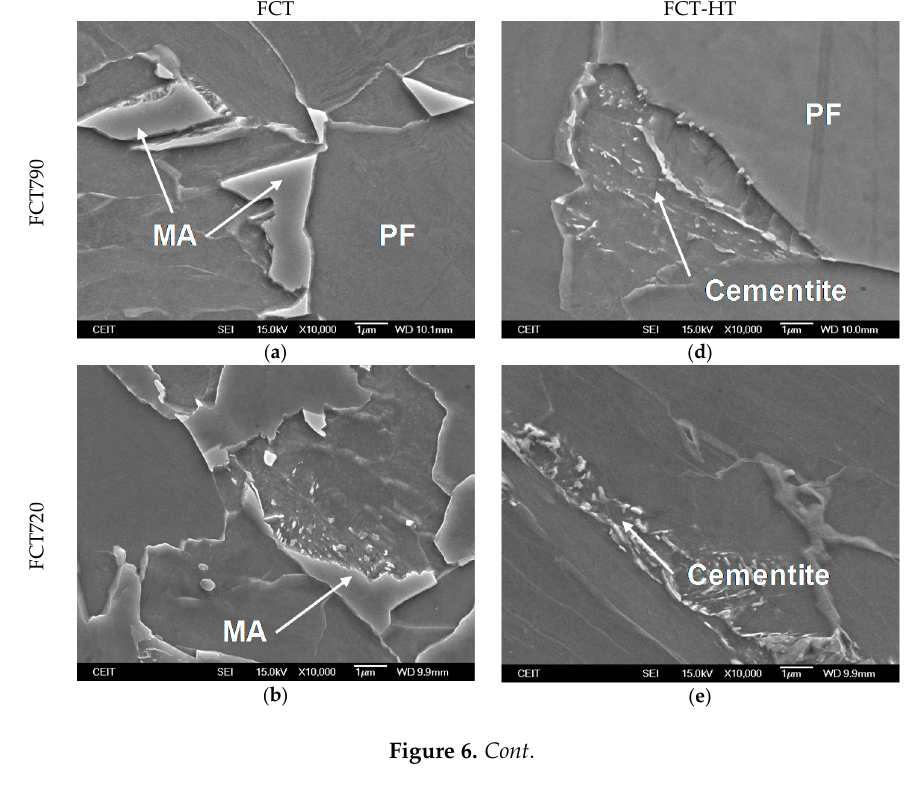
Figure 5. FEGSEM (field-emission gun scanning electron microscopy) micrographs corresponding to every Fast Cooling Temperature and both ( a – c ) FCT and ( d – f ) FCT-HT samples: ( a , d ) FCT790, ( b , e ) FCT720 and ( c , f )